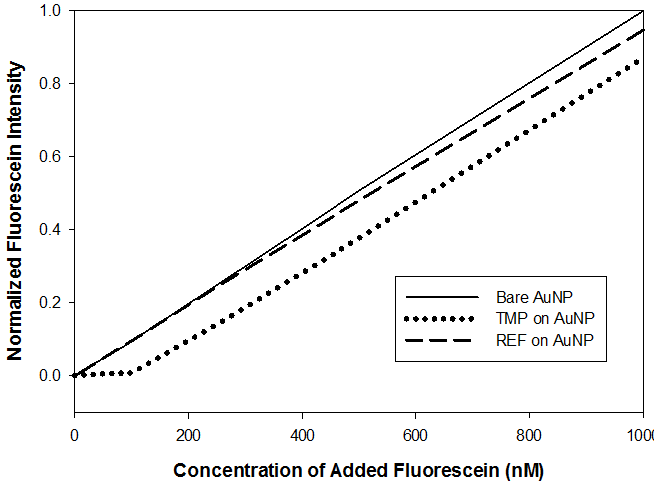
Figure 2. Transmission electron microscopy images of AuNP stabilized with TEM polymer. The scale bare is equal to 20 nm.